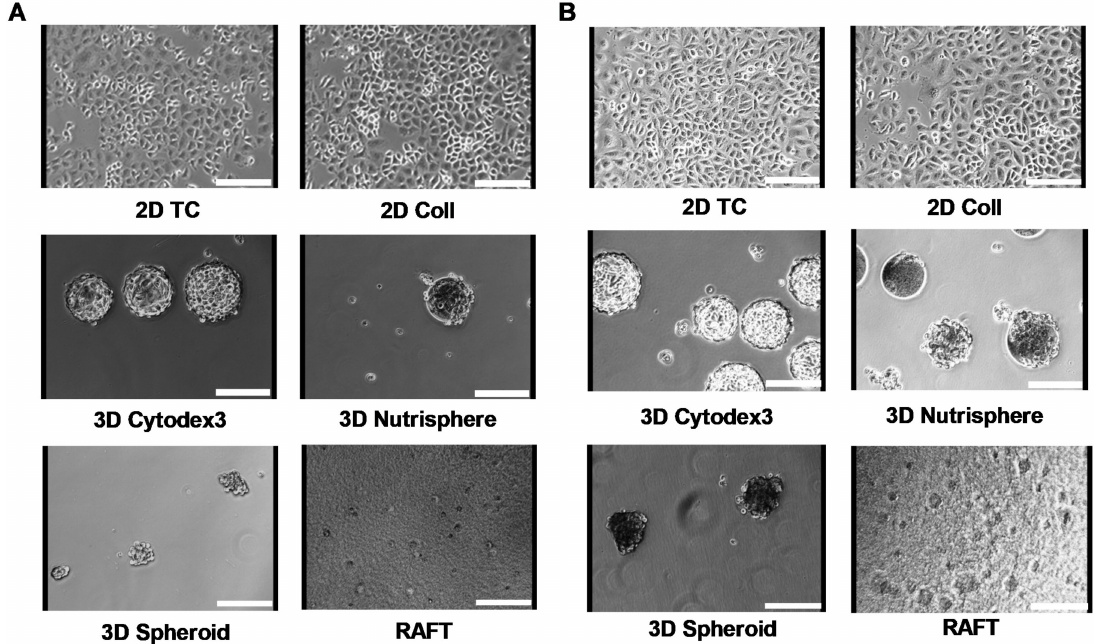
Figure 1. Di ff erent culture conditions of A549 human adenocarcinoma cells for 4 days ( A ) and for 9 days ( B ). Cells were seeded at the same surface / volume ratio regarding the di ff erent culture conditions as described in Materials and Methods. Images were taken by the HoloMonitor M3 instrument using phase contrast X10 objective. Scale bar: 150 µ